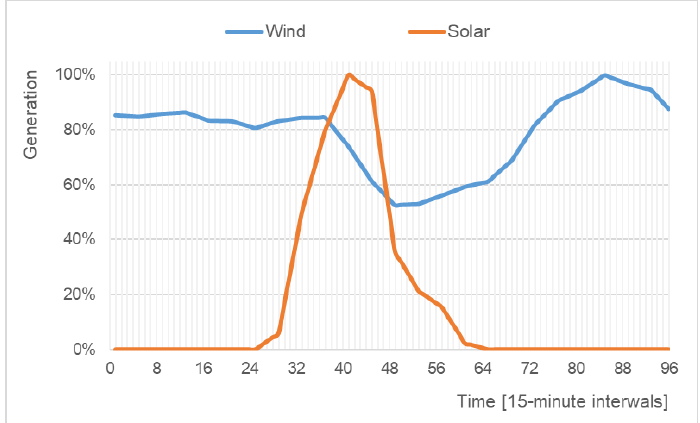
Figure 6. Generation profiles for wind and solar sources assumed for the simulation purposes (own development based on [26,27]).